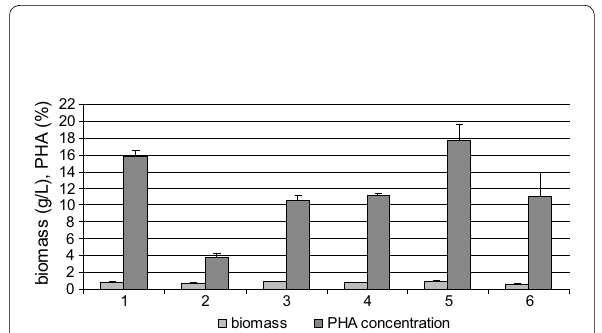
Fig. 1 Mcl‑PHAs content and biomass concentration of Pseu- domonas putida KT2440 wild‑type ( 1 and 2 ), P. putida KT2440 relA / spoT mutant ( 3 and 4 ) and P. putida KT2440 rpoN mutant ( 5 and 6 ). The shake flasks cultivation was performed under nitrogen limitation ( 1 , 3 , and 5 ) and optimal ( 2 , 4 , and 6 ) conditions. Each data represents the